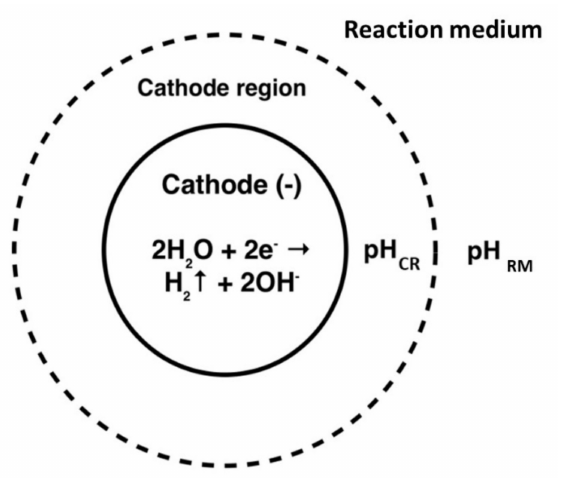
Figure 15. Scheme of pH change in the near-cathode volume (CR) of the reaction medium (RM) using the example of one carbon fiber